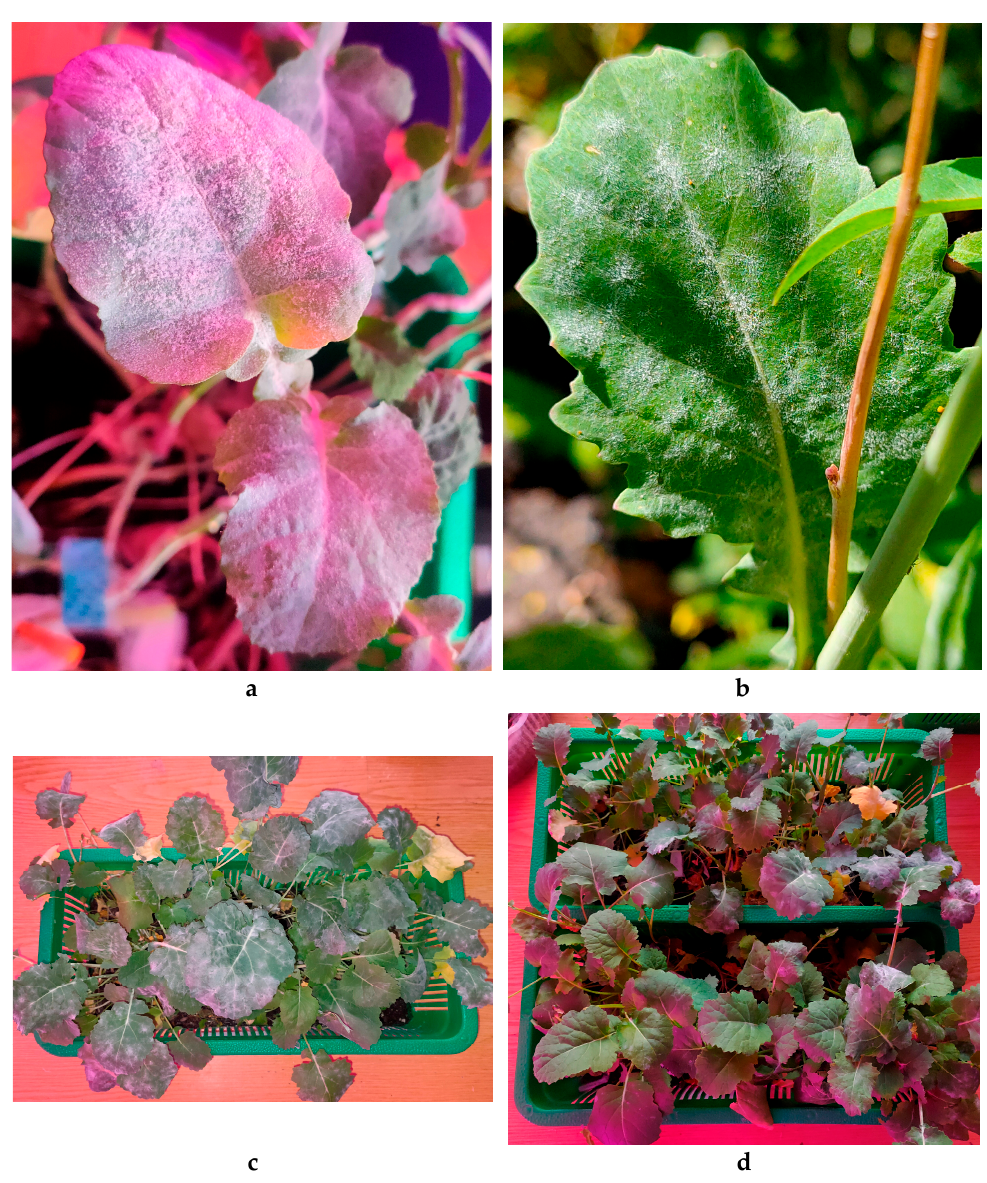
Figure 3. Degree of infection on WT B. napus ( a,c ) and transgenic plants ( b,d ). Plants with less than 30% coverage with white powdery growth were organized into a “resistant” group. Plants with 60% and more coverage were organized into a “susceptible” group [44] to investigate the reasons of resistance. Transgenic plants from laboratory and experimental plot were analyzed separately. No plant was free of infection; however, 84% of WT plants and only 23% of transgenic plants were severely infected (Figure 3). Samples from all groups were subjected to real time PCR (RT-PCR) analysis, GST activity analysis, GSH and GSSG assays.